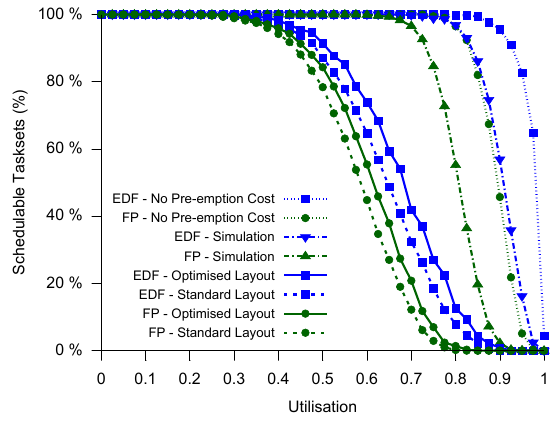
Figure 9 The percentage of schedulable tasksets at each utilisation level for the baseline configuration (taskset cardinality 15). Table 5 Weighted schedulability measures for the baseline configuration study shown in Figure 9. The higher the weighted schedulability measure, the more tasksets deemed schedulable by the